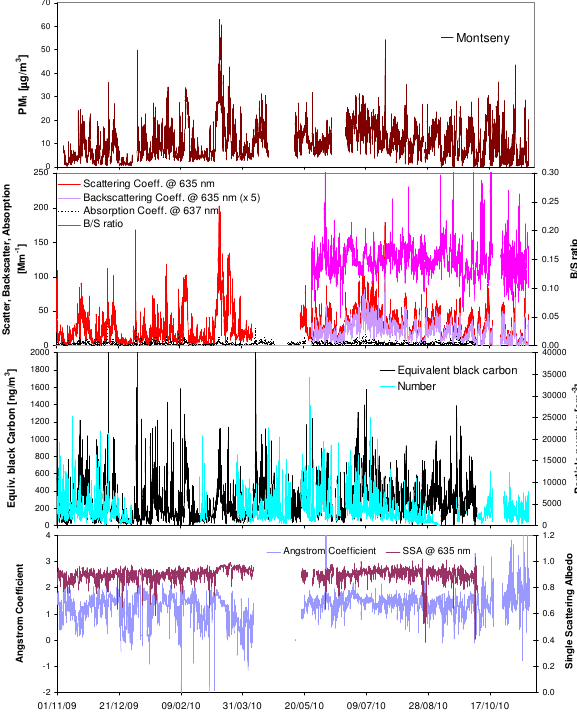
Fig. 3. Temporal series of PM 1 concentrations, scattering coef- ficient (635nm), hemispheric backscattering coefficient (635nm), absorption coefficient (637nm), backscattering-to-scattering ratio (B/S), equivalent black carbon (EBC) concentrations, particle num- ber, ˚Angstr¨om exponent, and Single Scattering Albedo (SSA) at